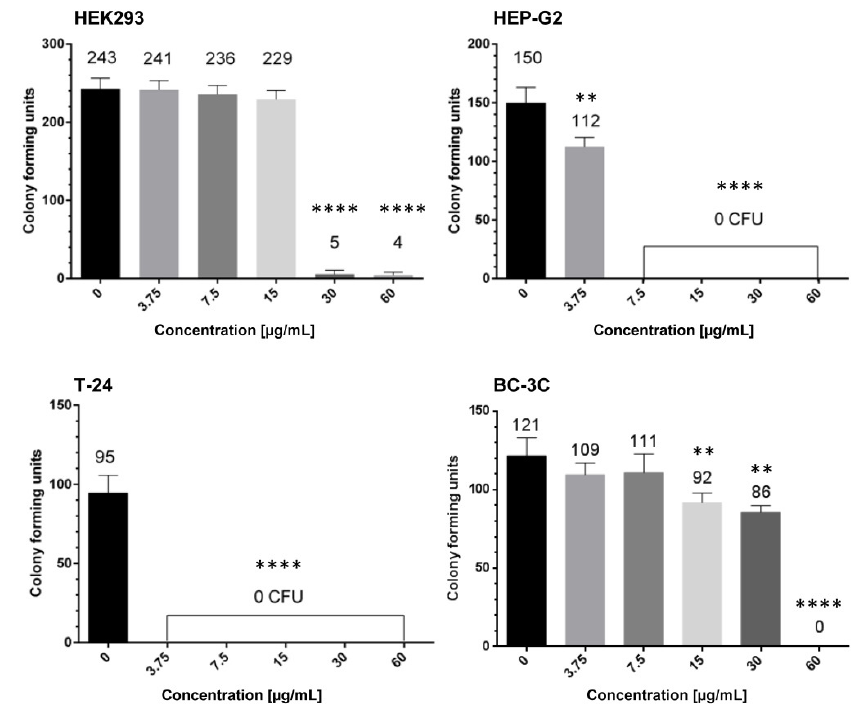
Figure 1. Clonogenicity of HEK293, T-24, BC-3C and HEP-G2 cells after treatment with EtOAc-AP extract of G. urbanum . The asterisks above the columns denote the p -value from the statistical analysis with one-way ANOVA obtained by comparison with the untreated control—** p < 0.01, **** p < 0.0001; the numbers above the columns represent the number of colonies.